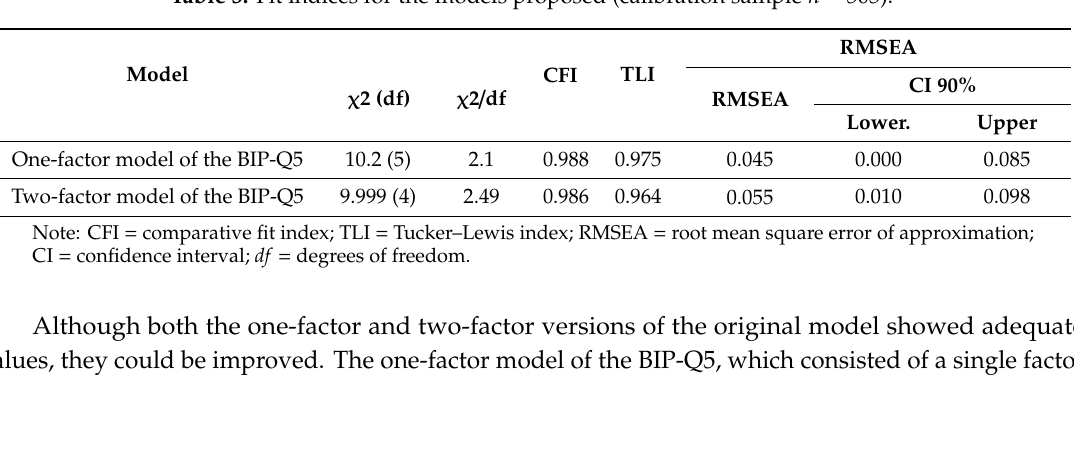
Table 3. Fit indices for the models proposed (calibration sample n =